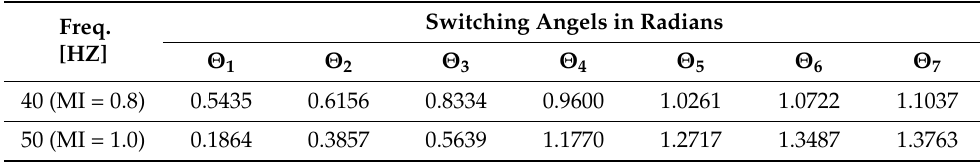
Table 2. Switching angles for SHE for 40 and 50 Hz.